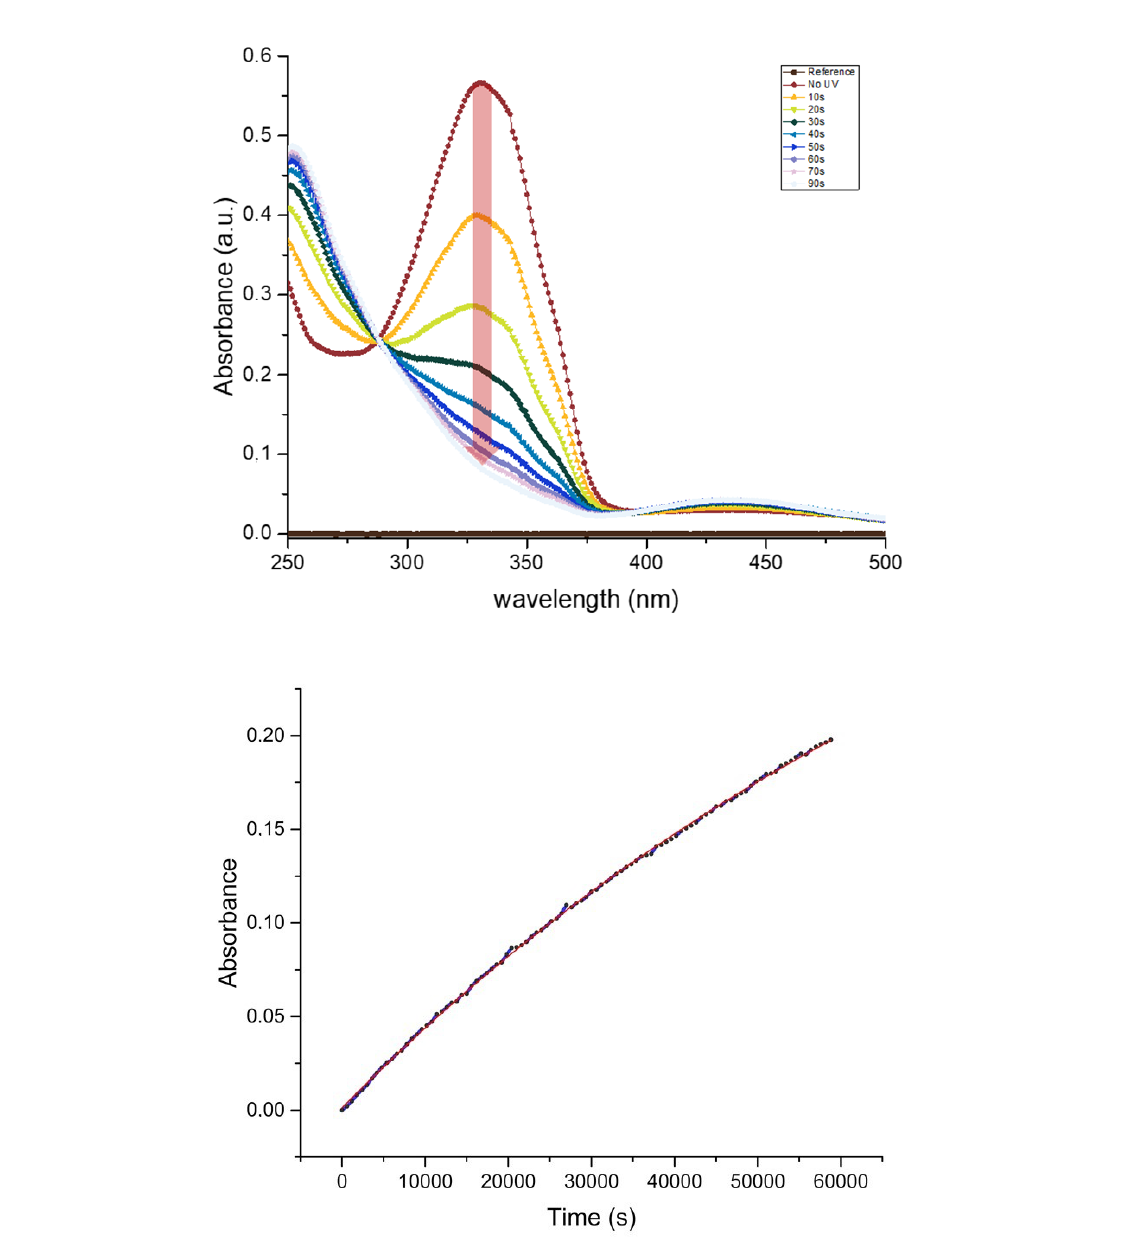
Figure 5. ( Upper ) Conversion of the surfactant state under UV illumination, Top curve (red) being the first measurement with no UV treatment and subsequent state change transition of surfactant by 10 s of exposure to a UV lamp with power of 6.7 mW at 365 nm wavelength; ( Bottom ) slow exponential rise of the 335 nm absorption band intensity of the t-KryAz600 form in dark, this corresponds to a half-life t 1/2 (cid:39) 18 h of the c-KryAz600 → t-KryAz600